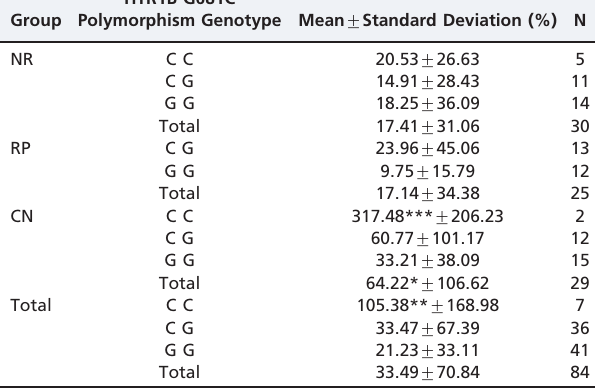
Table 4 - A comparison of the prolactin maximal percent of variation among the eight subgroups based on the three groups of participants and the G681C HTR1B polymorphism genotypes.